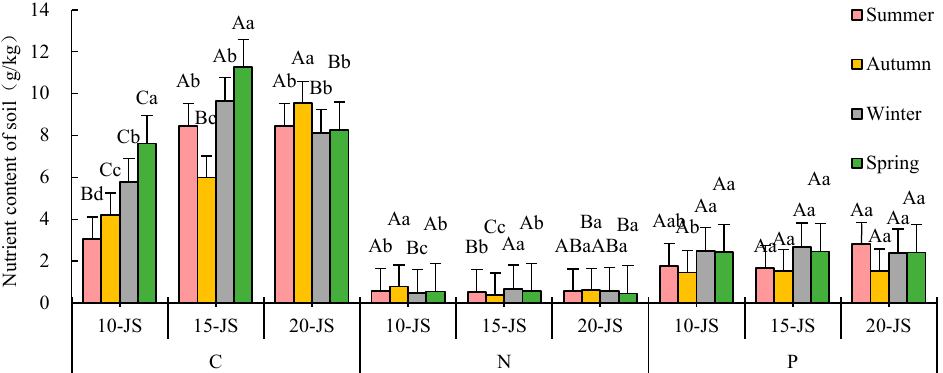
Figure 5. The contents of soil C, N and P under different precipitation patterns. Note: capital letters on different columns indicate that the soils in the same season were significantly different under different precipitation ( p < 0.05); lowercase letters on different columns indicate that the soils in the same precipitation had significant difference in different seasons ( p < 0.05).